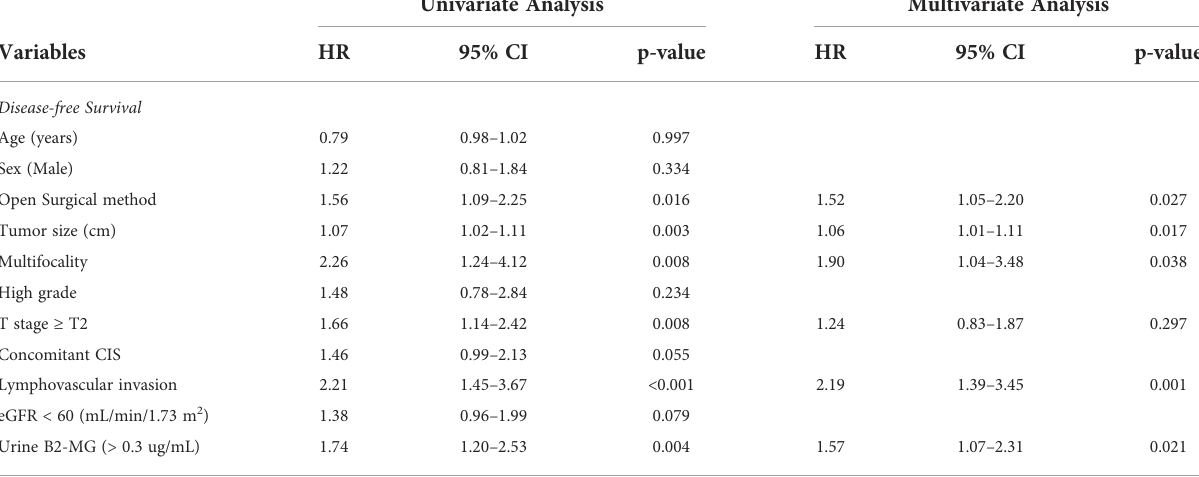
TABLE 4 Univariate and Multivariate Cox regression analysis of disease-free